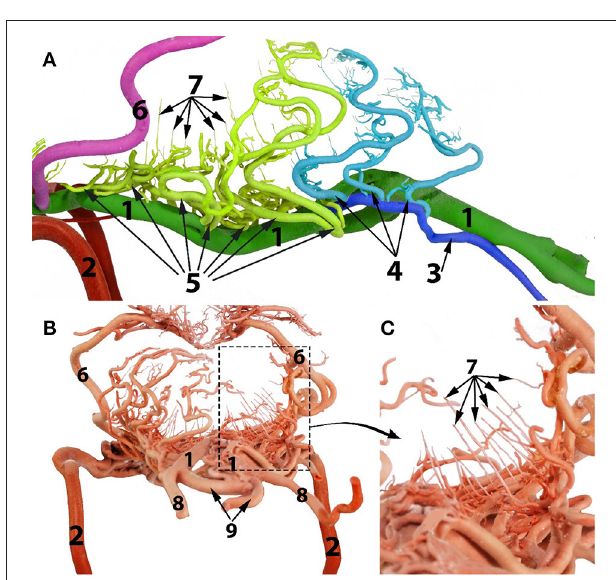
FIGURE 5 | Arterial supply to the medulla oblongata of the dromedary brain. (A) left lateral view; (B) caudal view; (C) magnified part of the image (B) to show the straight vertical medullary branches. 1, basilar artery 2, internal carotid artery; 3, lateral branch of the vertebral artery; 4, medullary branches from the lateral branch of the vertebral artery; 5, medullary branches from the basilar artery; 6, caudal cerebellar artery; 7, median, paramedian and lateral medullary branches; 8, vertebral artery; 9, ventral spinal artery.